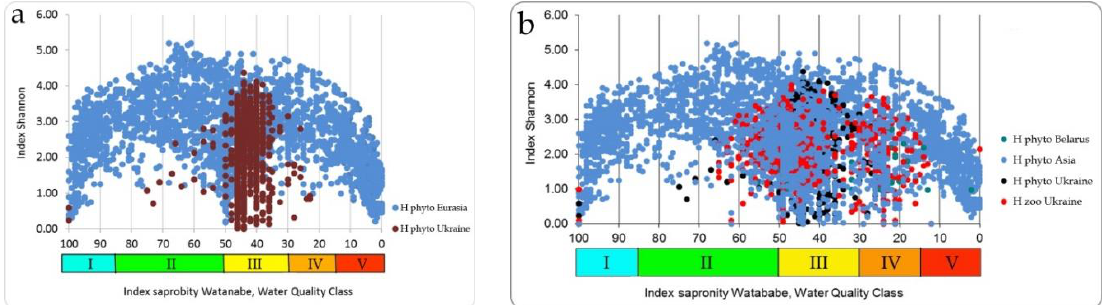
Figure 10. The distribution of Shannon's species diversity indices in the model (blue dots) and for the algae communities of Ukrainian waterbodies (the brown dots) ( a ) and jointly plankton algae (black dots) and consumers of plankton, benthos, periphyton (red dots) ( b ) in the studied water bodies of Ukraine.